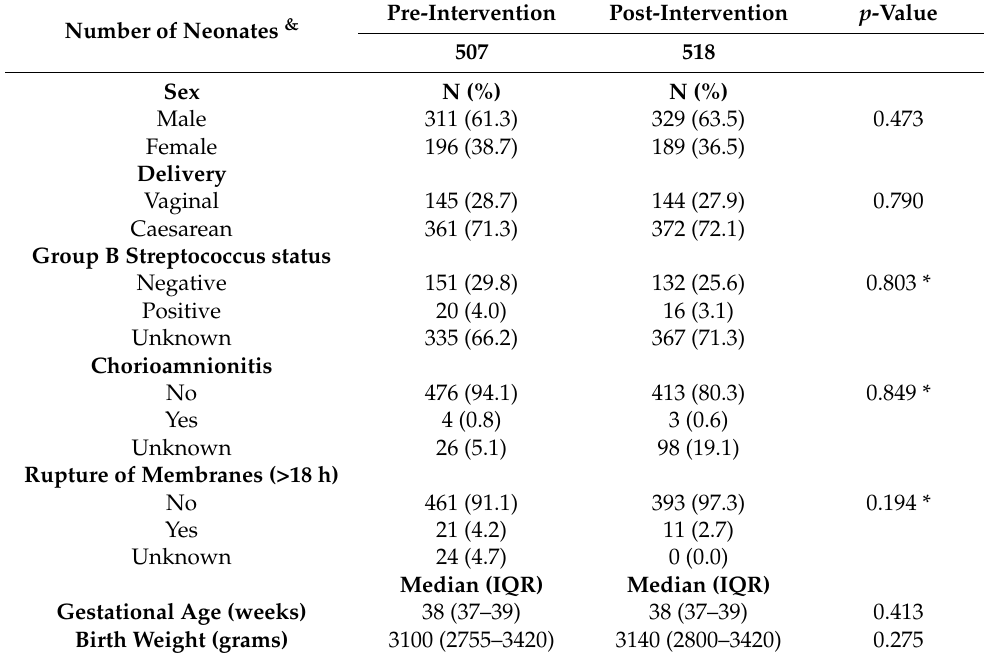
Table 1. Demographic and clinical characteristics, maternal and neonatal, in the pre- and post- intervention